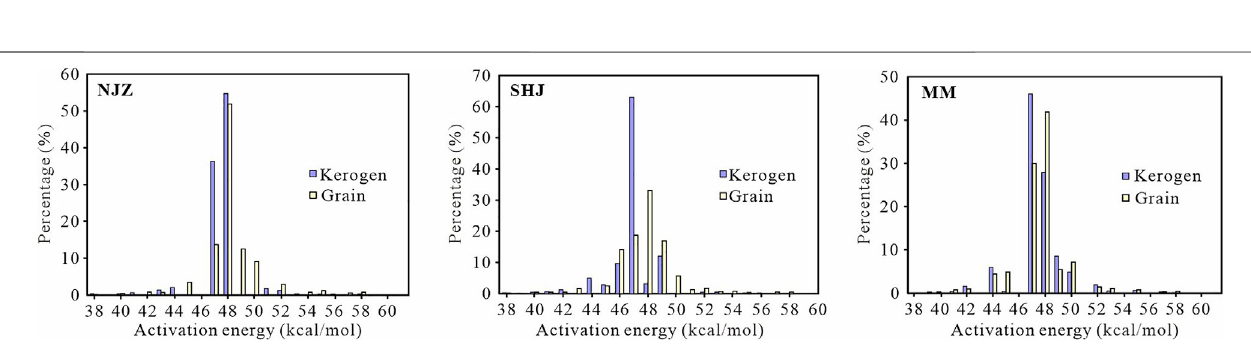
FIGURE 7 | Distribution of activation energies with the universal frequency factor (A) for grain and kerogen from NJZ shale, SHJ shale, and MM oil shale.